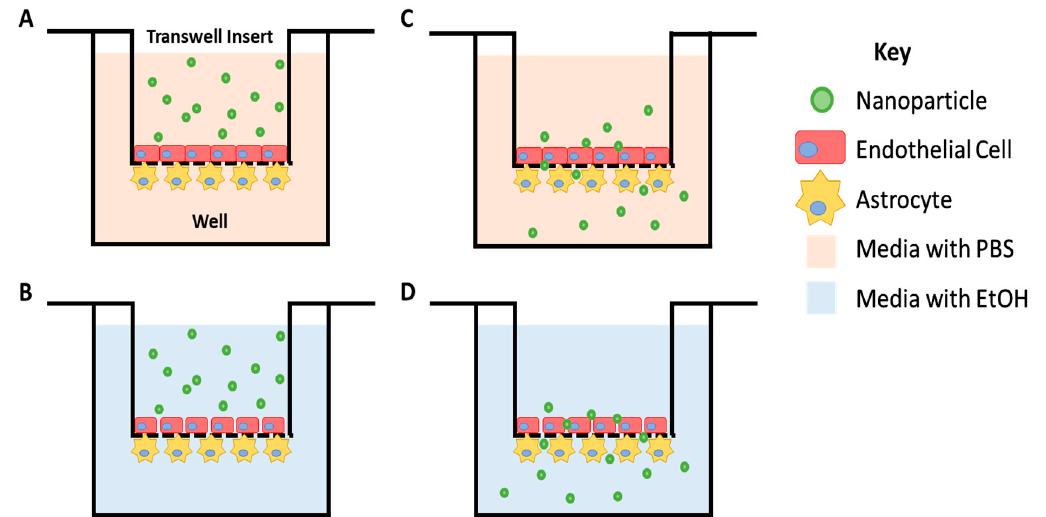
Figure 8. Cartoon depicting the transwell scheme. Primary rat brain microvascular endothelial cells were cultured on the 3 μ m pore transwell insert while astrocytes were cultured underneath the insert. Nanoparticles were suspended in the basal medium ( A ) or a medium containing 20 mM of EtOH ( B ) and added to the transwell insert. ( C , D ) The movement of nanoparticles across this barrier, towards the well, was monitored over time.